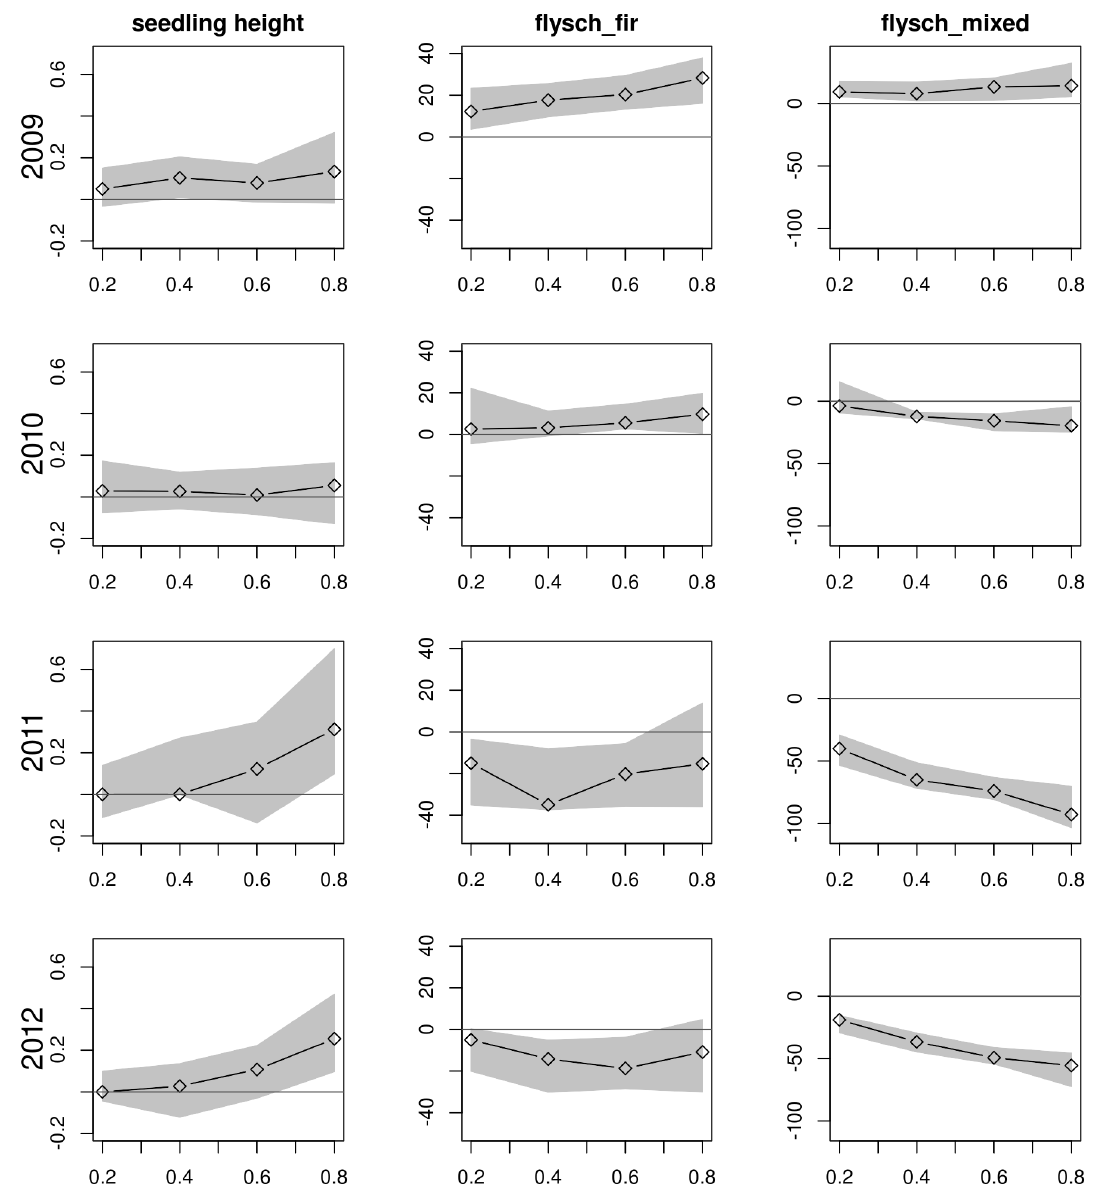
Figure 3. Coe ffi cients of quantile regression models and 0.95 confidence intervals of seedling apical growth (mm) on initial height (mm) and site groups for di ff erent tau’s (horizontal axis). Coe ffi cients for site groups flysch_fir and flysch_mixed indicate di ff erences with site group